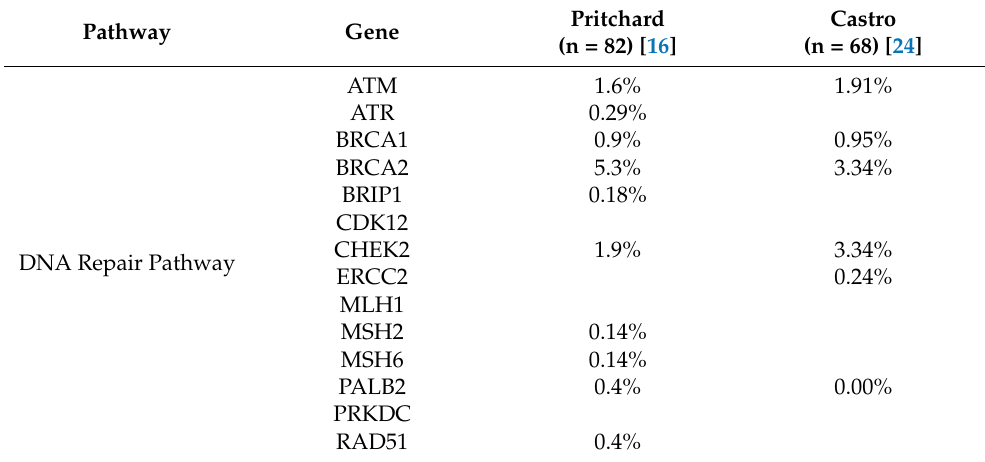
Table 3. Summary of reported germline DNA Repair Pathway genetic aberrations in